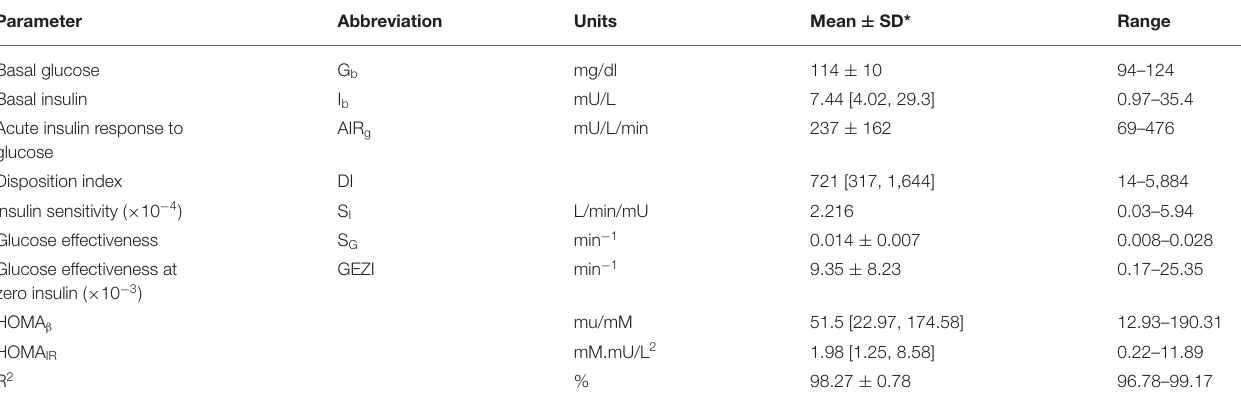
TABLE 1 | Basal glucose and insulin concentrations, and results from minimal model analysis of FSIGTT.